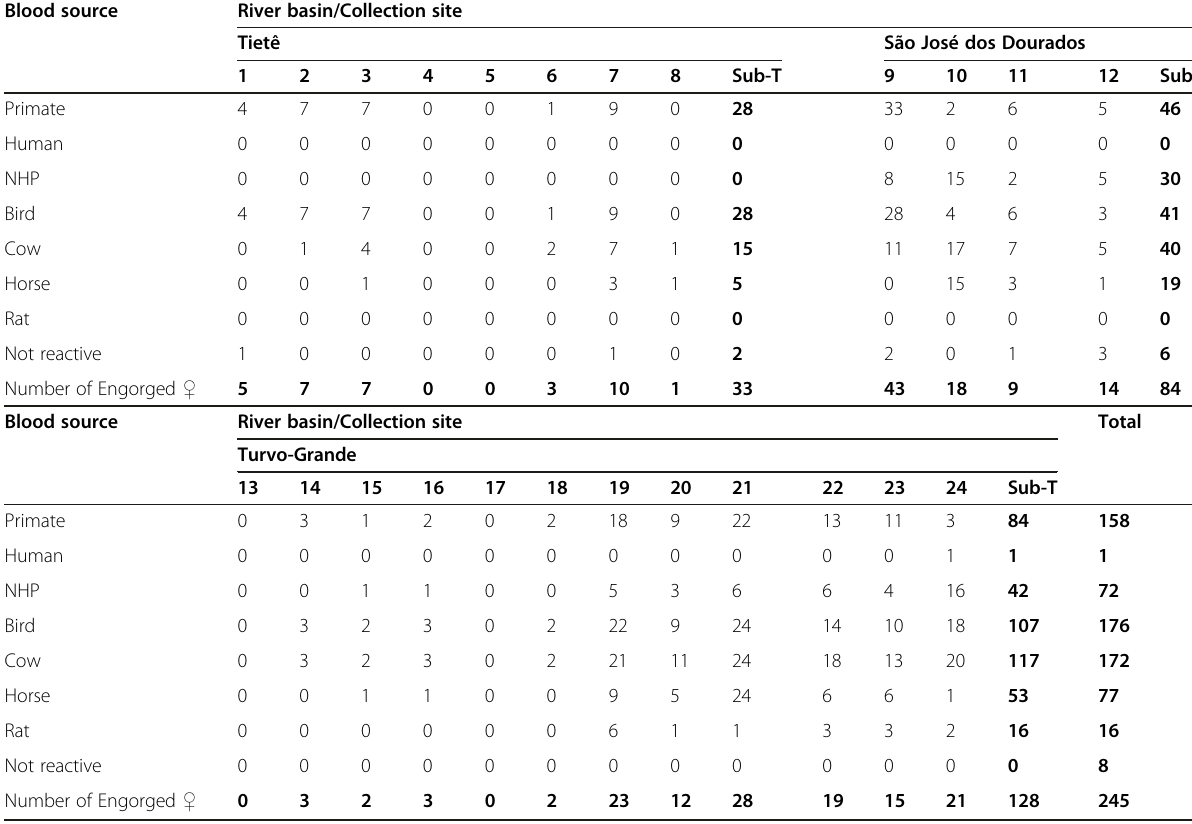
Table 3 Number of samples by type of blood source, collection point and river basin Blood source